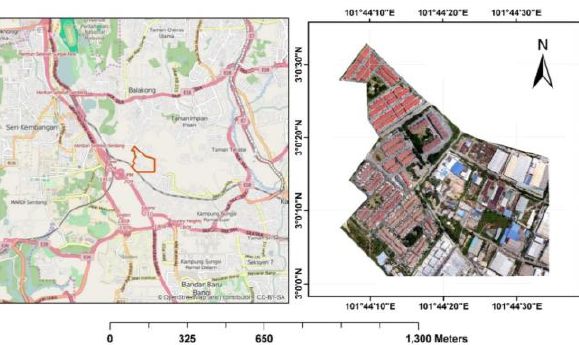
Figure 1. Location of study area presented by OpenStreetMap (left), and aerial orthophoto (right).